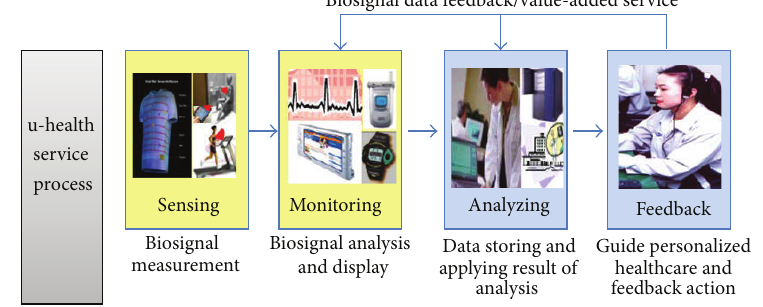
Figure 1: General process of u-health service.